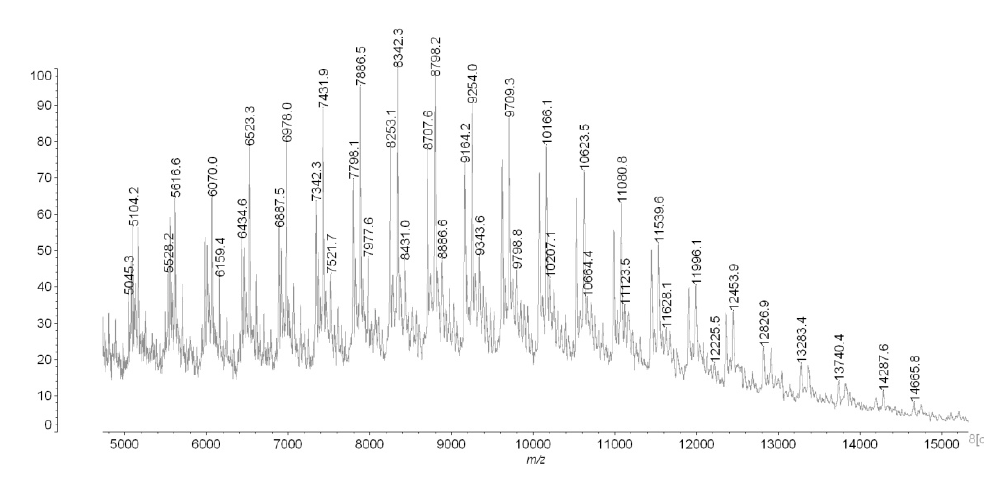
Figure 4. Simplified scheme macromolecule with two branches (* means places of chain growth).